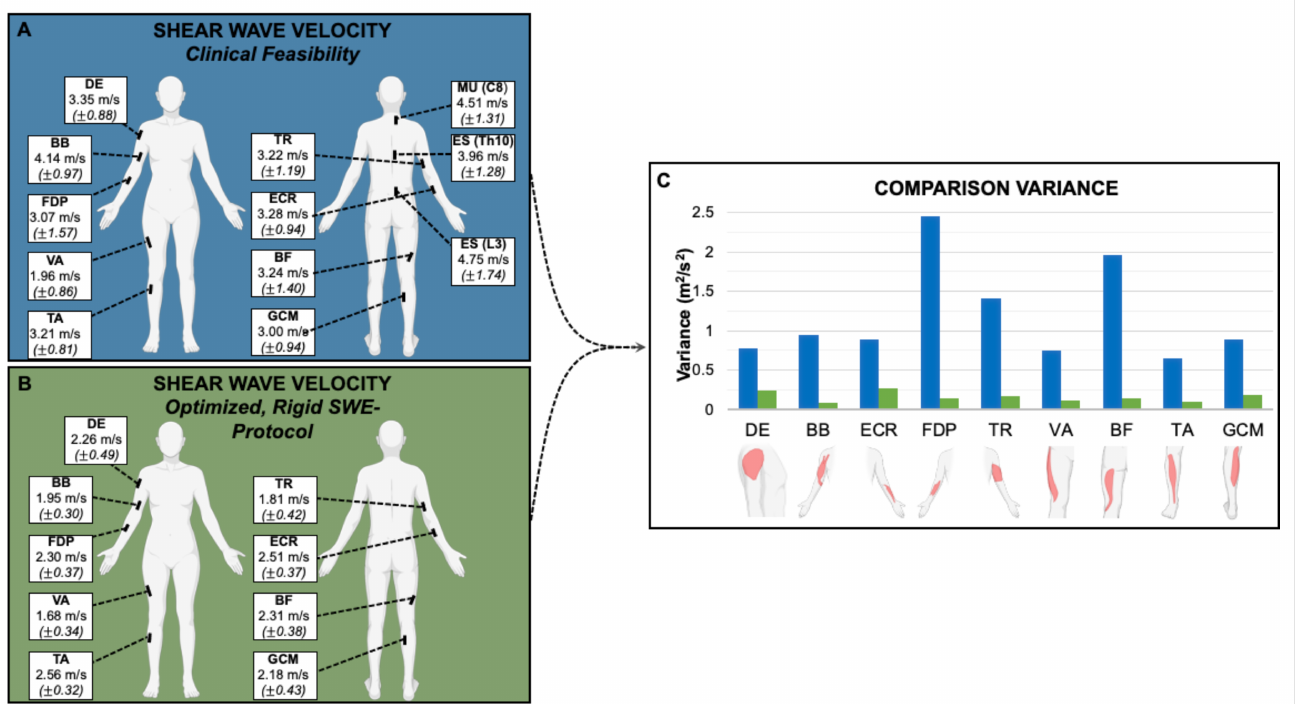
Figure 1. Representation of the muscle measurement locations with the average SWV in m/s and the corresponding standard deviation ( ± ) of Protocol 1 ( A ) and 2 ( B ) and comparison of the variance between them ( C ): The variances of measurements acquired using Protocol 2 (optimized, rigid SWE-protocol) were significantly lower ( p < 0.001) than under Protocol 1 (clinical feasibility). DE = deltoideus. BB = biceps brachii. ECR = extensor carpi radialis. FDP = flexor digitorum profundus. TR = triceps brachii. MU (C8) = multifidus (C8). ES (Th10) = erector spinae (Th10). ES (L3) = erector spinae (L3). VA = vastus lateralis. BF = biceps femoris (caput longum). TA = tibialis anterior. GCM = gastrocnemius (caput